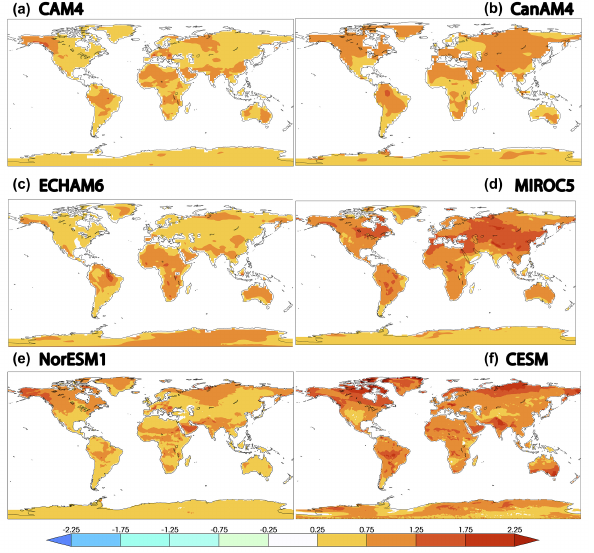
Figure 2. Differences in average hot season surface air tem- perature ( ◦ C) between the 1.5 ◦ C and present-day HAPPI simu- lations. (a) CAM4. (b) CanAM4. (c) ECHAM6. (d) MIROC5. (e) NorESM1. (f) CESM.